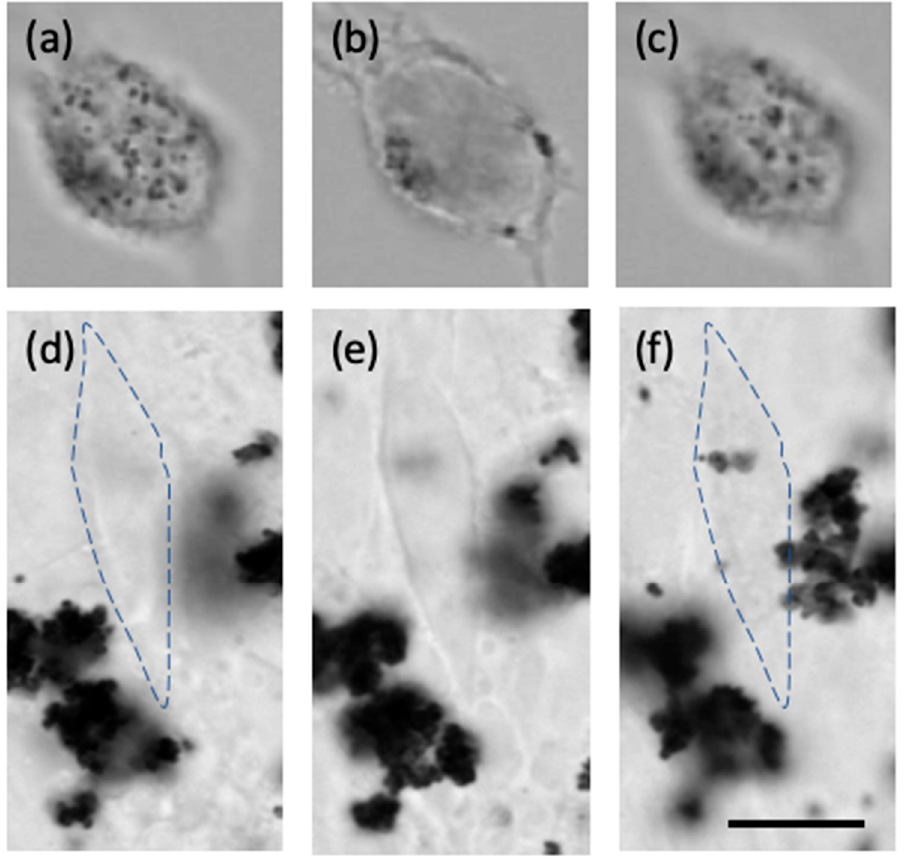
Figure 3. Optical microscope images of a VM-M3 cell ( a , b , c ) and a VM-NM1 cell ( d , e , f ), taken at changing focal plane depths: near the top cell surface ( a , d ), middle of the cell ( b , e ), and near the bottom cell surface ( c , f ). Both cells are shown after 26 h incubation with mNPs. The common scale bar is 10 m. The dashed line in ( d ) and ( f ) outlines the cell shape as in ( e ).